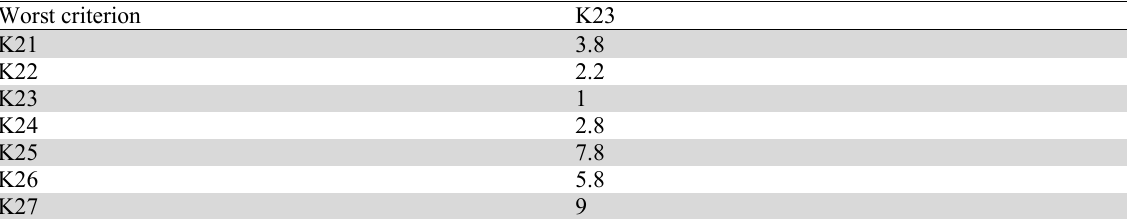
Institutions sub-criteria OW Vector